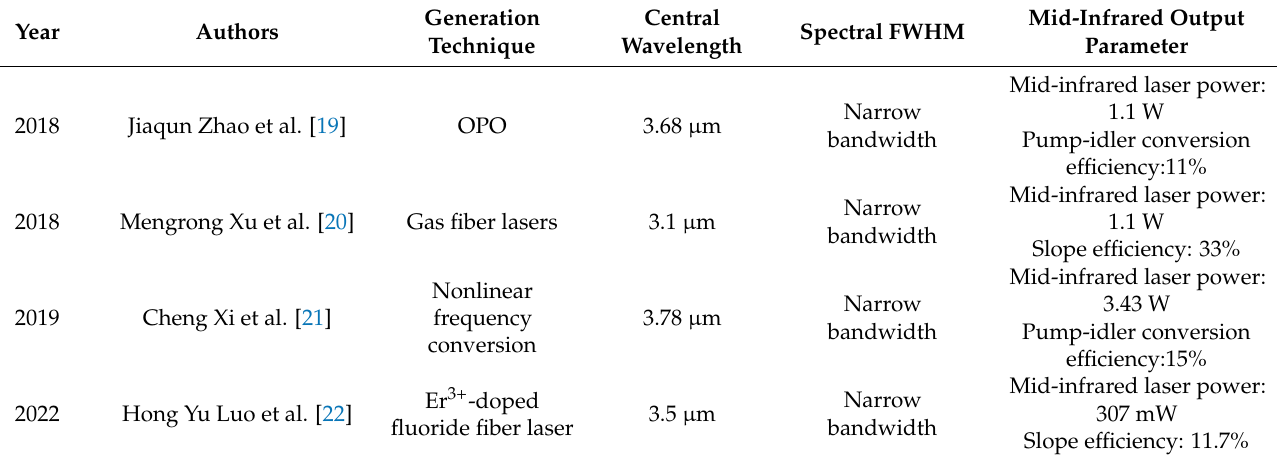
Table 1. Research on and development in 3–4 µ m CW mid-infrared